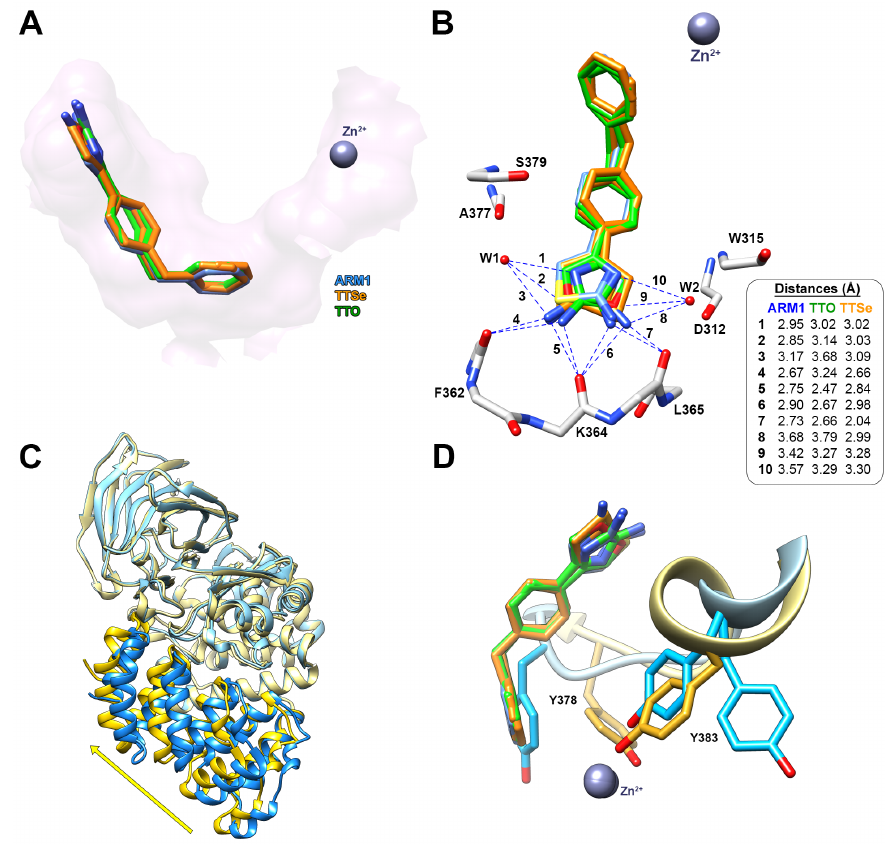
Figure 7. The binding mode of TTSe and TTO in LTA 4 H. ( A ) TTSe (orange), TTO (green) and ARM1 (blue) are bound to the end of the substrate channel of LTA 4 H; ( B ) Distances of hydrogen bonds between inhibitors, the polypeptide chain of LTA 4 H and water molecules (W1 and W2); ( C ) The domain movement from open (blue; PDB ID: 5NIA) to closed conformation (yellow) induced by selective inhibitors; ( D ) the inhibitor-induced rotation of Y378 and Y388 into the activated state of LTA 4